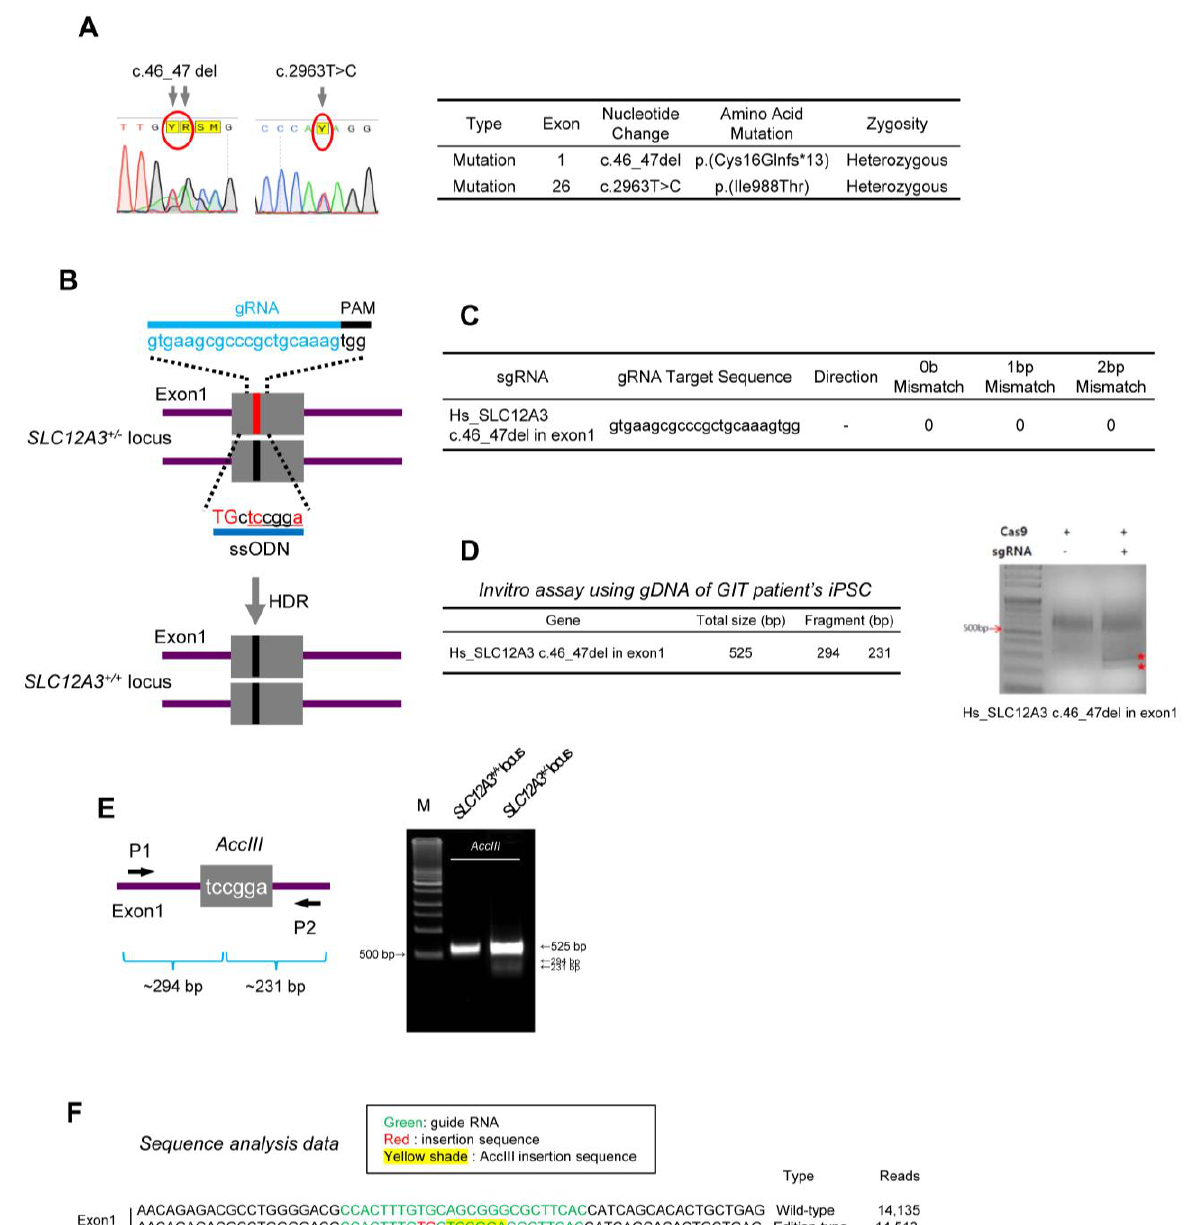
Figure 1. Establishment of CRISPR/Cas9 RNP-mediated SLC12A3 gene editing of CMC-GIT-001 iPSCs. ( A ) Sequencing analysis showing SLC12A3 gene mutation. ( B ) Strategy for correcting SLC12A3 mutation. The sequence of gRNA is shown with the PAM sequence. The red line represents the mutant allele, and the blue line represents the wild-type allele. HDR, homology-directed repair; ssODN, single-stranded oligodeoxynucleotide. The red uppercase letters highlight the corrected base. ( C ) sgRNA target site sequence. ( D ) In vitro assay result using gDNA from GIT patient hiPSCs. ( E ) PCR validation using digestion of PCR products before and after gene correction in either exon 1 by AccIII enzyme. ( F ) Confirmation of SLC12A3 gene correction in CMC-GIT-001 hiPSCs by DNA sequencing. Enzyme sites are highlighted with a yellow shade. Corrected sequences are highlighted in red.